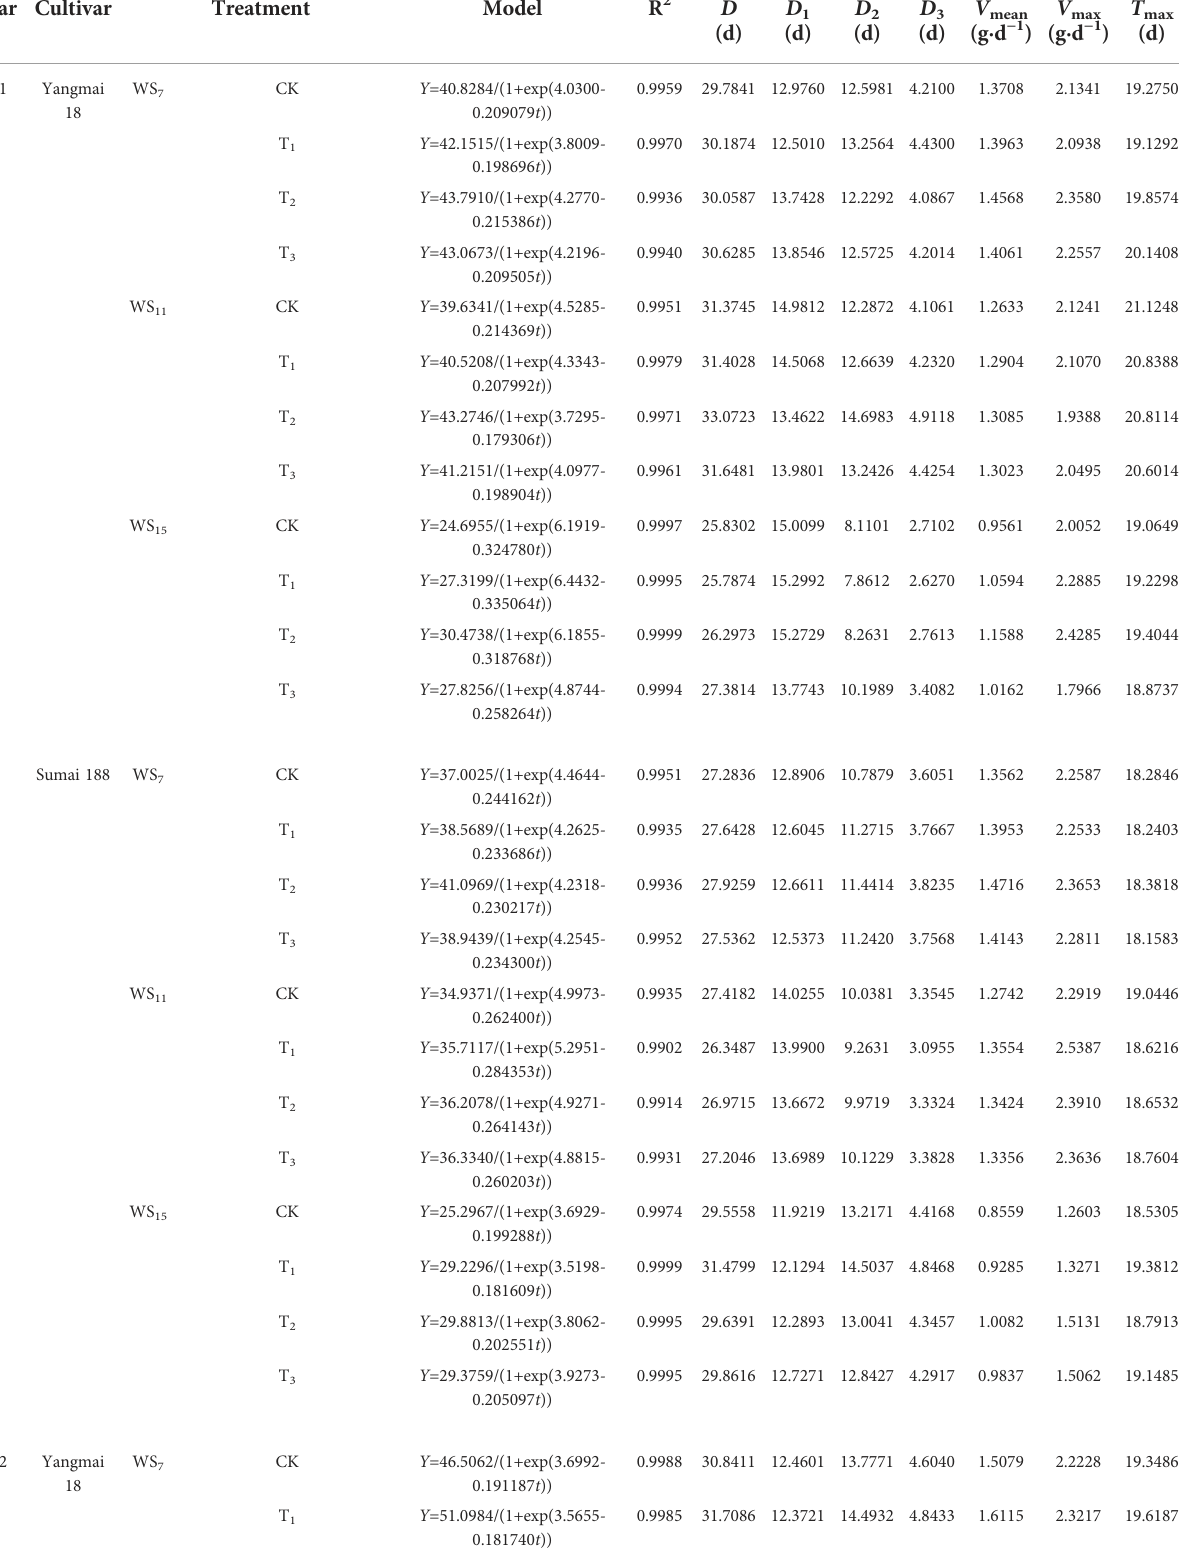
TABLE 4 The effect of exogenous 6-BA on the grout characteristic of wheat grain under waterlogging and shading. Year